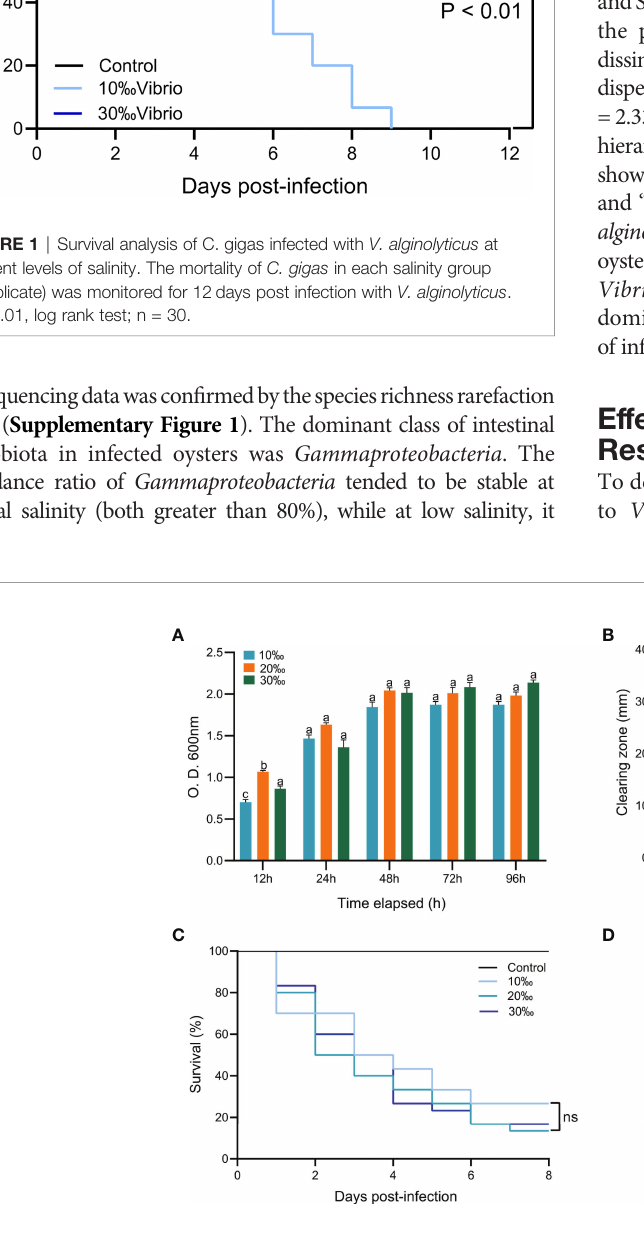
FIGURE 2 | Effect of low salinity on growth and virulence of V. alginolyticus . (A) Effect of salinity on growth of V. alginolyticus . Bacterial amounts were determined at 12, 24, 48, 72 and 96 h. Each bar represents the mean ( ± S.E.) of three determinations. The same letter at the same time point indicates that the difference is not signi fi cant. (B) Effect of salinity on amylase, lipase and lecithinase activities of V. alginolyticus . Each bar represents the mean ( ± S.E.) of three determinations. The same letter at the same time point indicates that the difference is not signi fi cant. (C) Survival analysis of oysters infected with V. alginolyticus cultured with different levels of salinity. n=30, in triplicate; ns, not signi fi cant. (D) The high mortality of oysters caused by low salinity is not achieved by affecting the growth and virulence of V. alginolyticus .